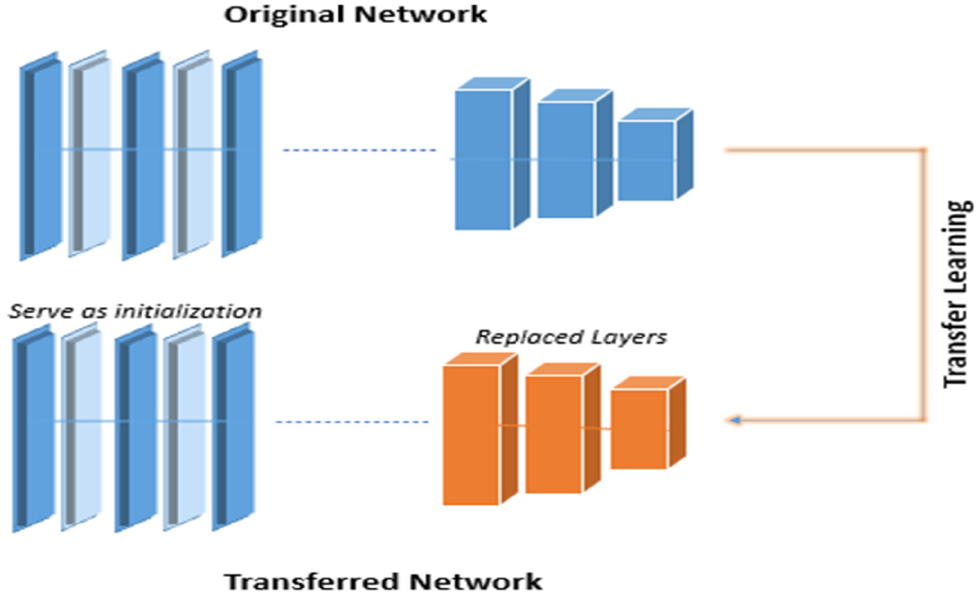
Figure 4. Transfer learning of networks.